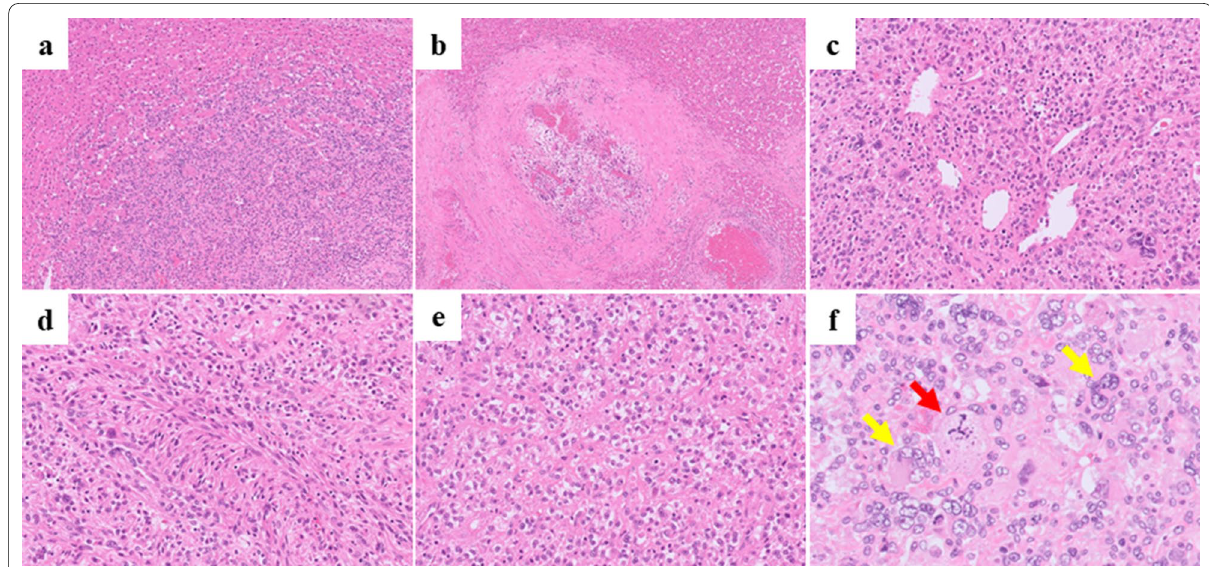
Fig. 5 Histopathological findings (microscopic). The tumor shows an infiltrative growth pattern ( a ) and vascular invasion is also noted ( b ). The tumor is composed of polygonal or oval-shaped cells arranged around blood vessels ( c ), spindle cells arranged in fascicles ( d ), and round epithelioid cells with clear cytoplasm ( e ). Multinucleated giant cells are also noted ( f , highlighted with yellow arrows). Mitotic figure was easily recognized, including abnormal mitosis ( f , highlighted with a red arrow)